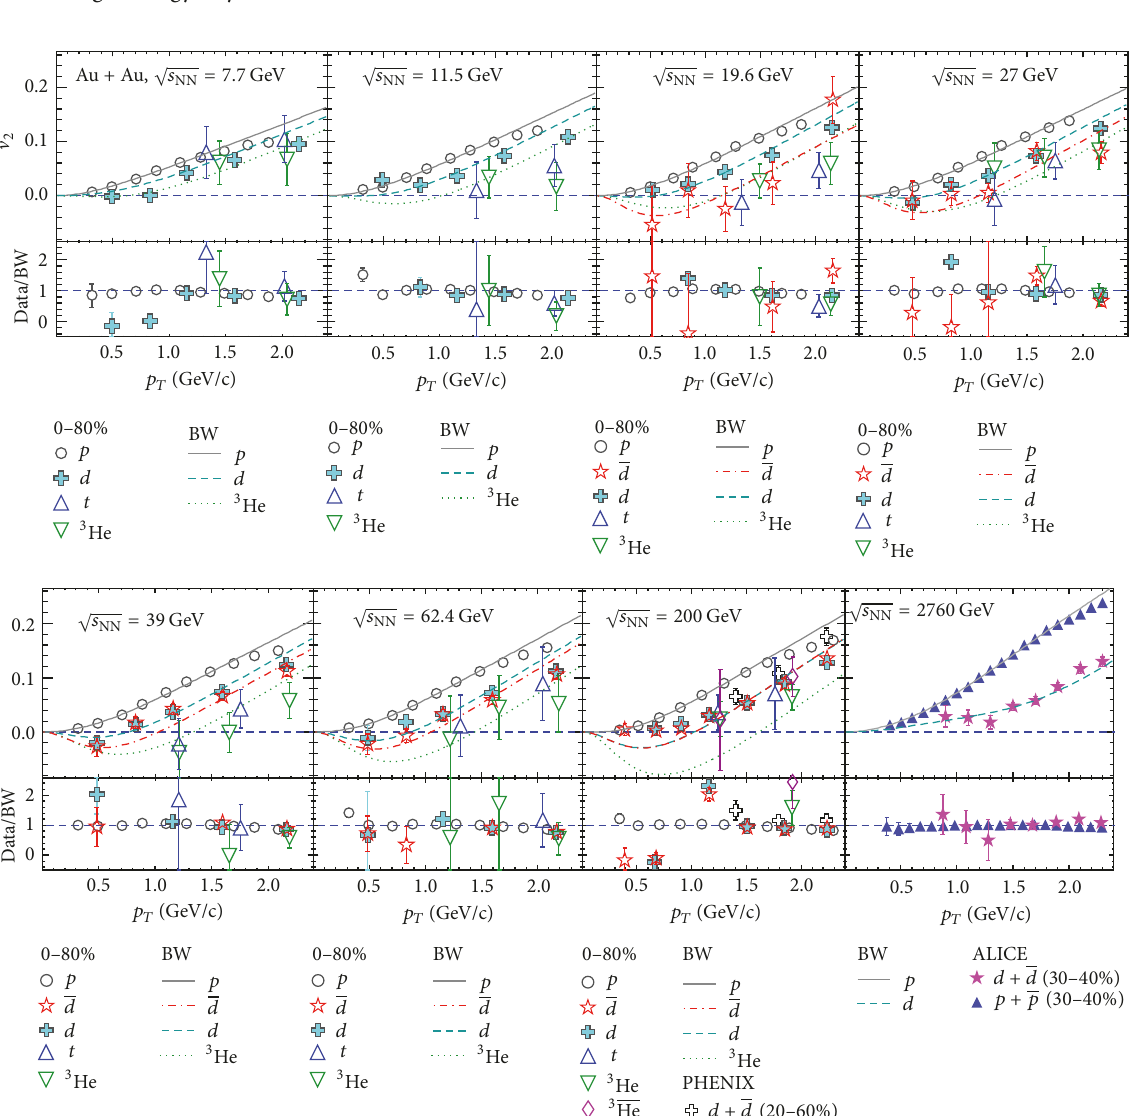
Figure 7: Light nuclei V 2 as a function of 𝑝 𝑇 from blast-wave model (lines). For comparison, 𝑝 + 𝑝 V 2 is also shown. Marker for STAR corresponds to 0–80%, PHENIX corresponds to 20–60%, and ALICE corresponds to 30–40% central events.